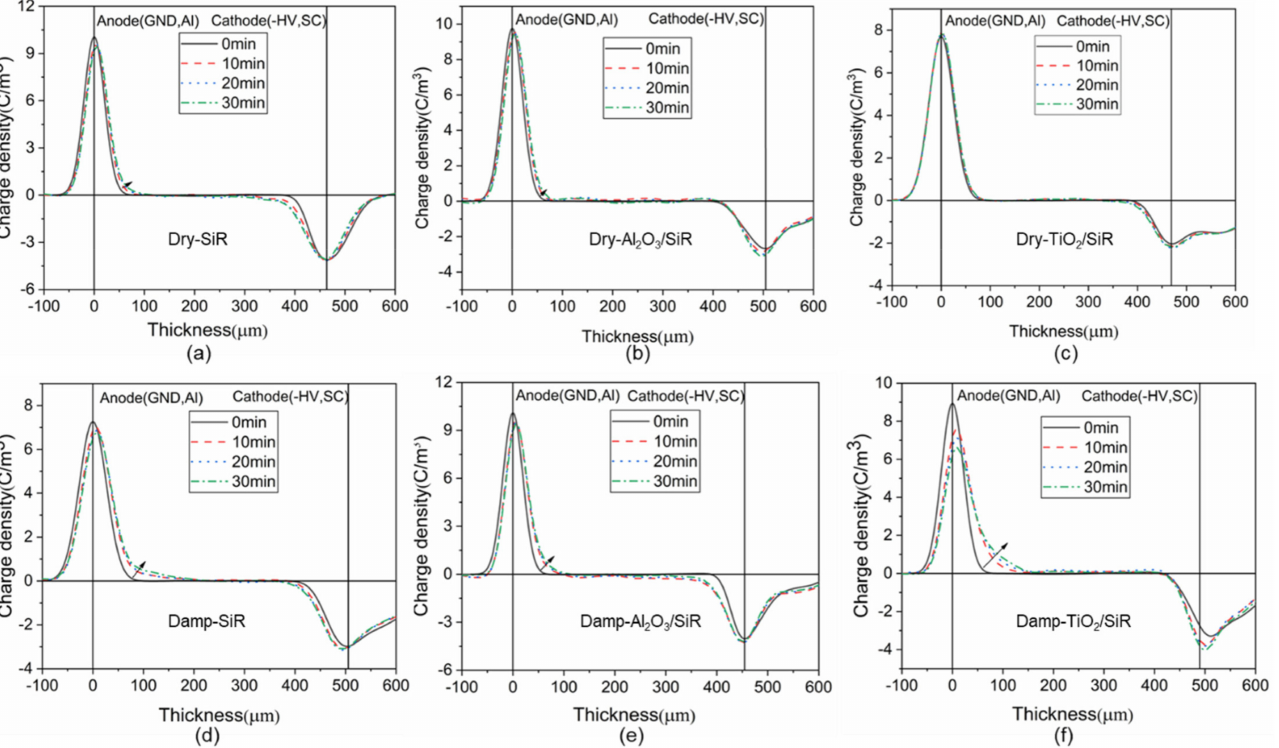
Figure 6. Space charge distribution of SiR ( a ) Dry SiR, ( b ) Dry Al 2 O 3 /SiR, ( c ) Dry TiO 2 /SiR, ( d ) Damp SiR, ( e ) Damp Al 2 O 3 /SiR, ( f ) Damp TiO 2